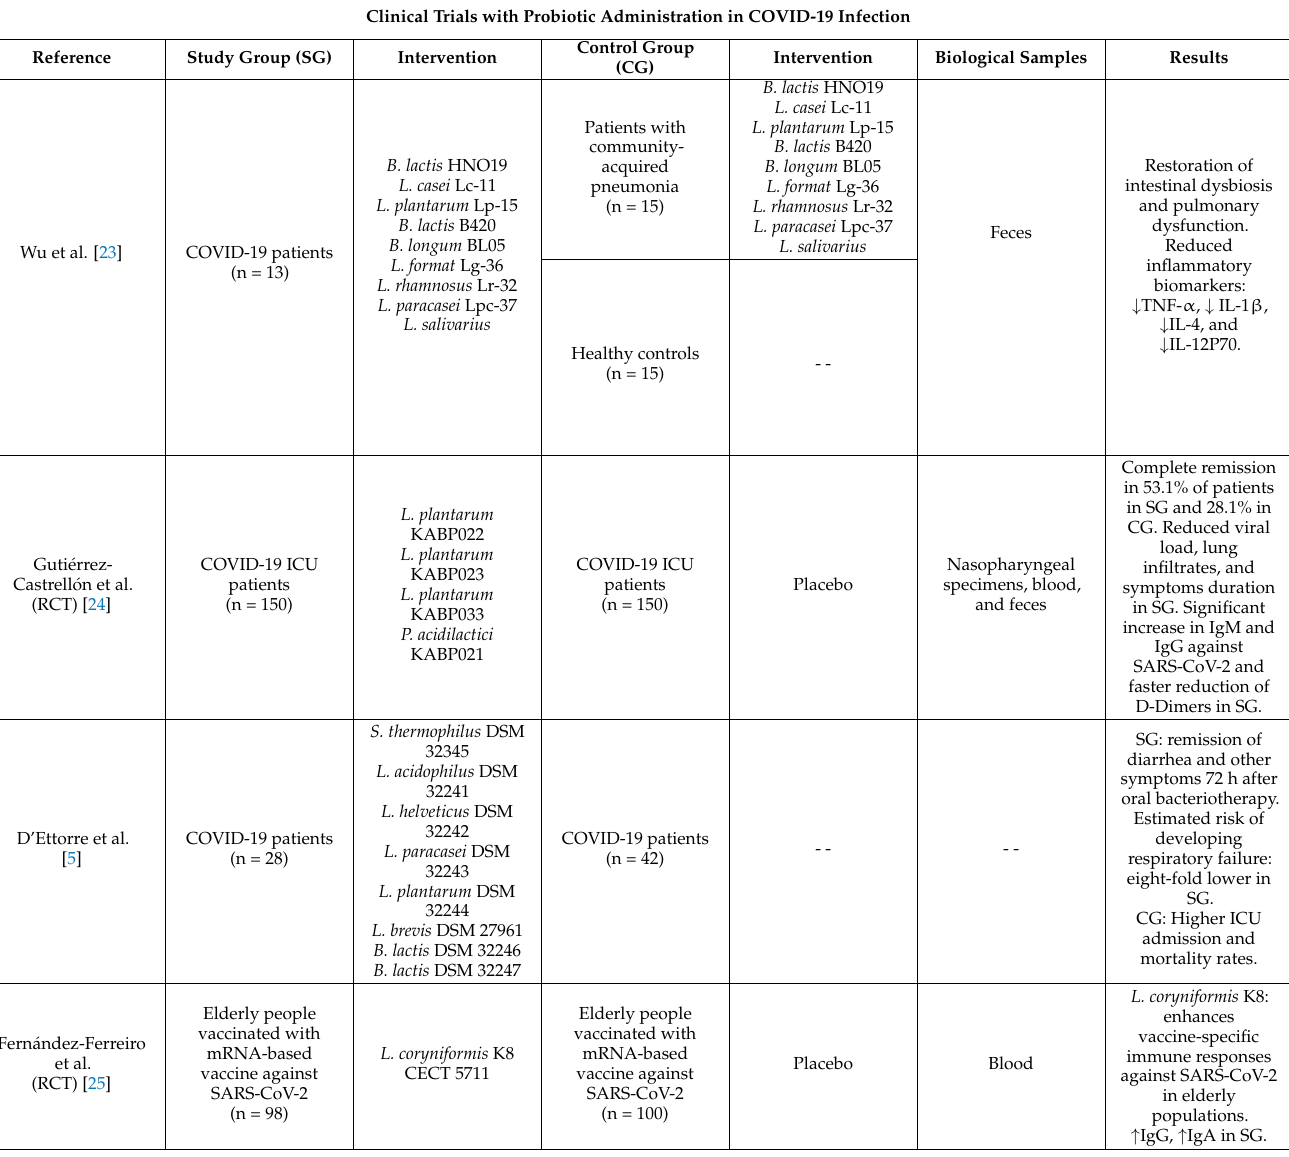
Table 1. Clinical trials with probiotic administration in COVID-19 infection. Clinical Trials with Probiotic Administration in COVID-19 Infection